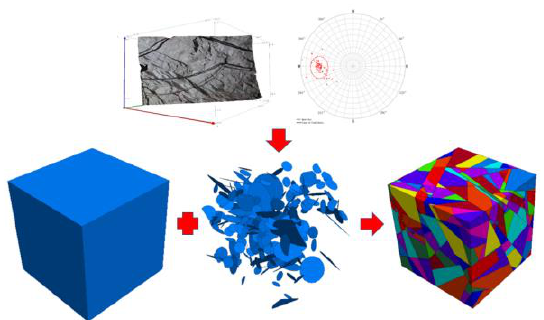
Figure 2. Process of parameter reduction method to obtain rock mass parameters.